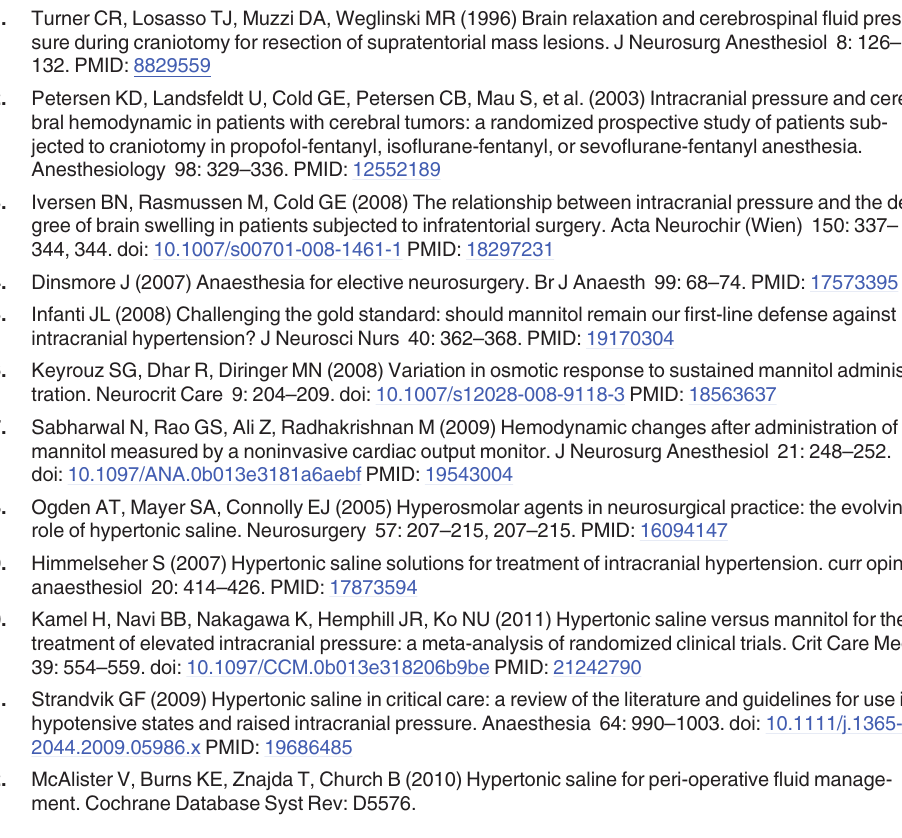
S1 Table. Baseline characteristics of the seven included trials. S2 Table. Risk of bias and quality assessment of the seven included